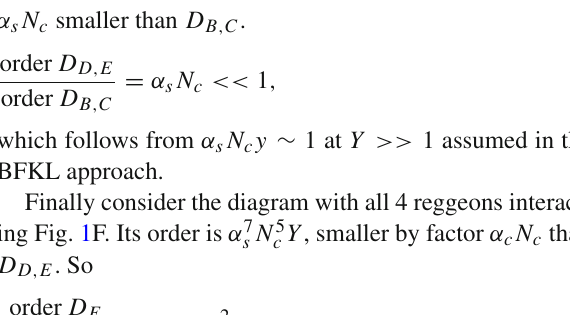
Fig. 2 Color redistribution of 4